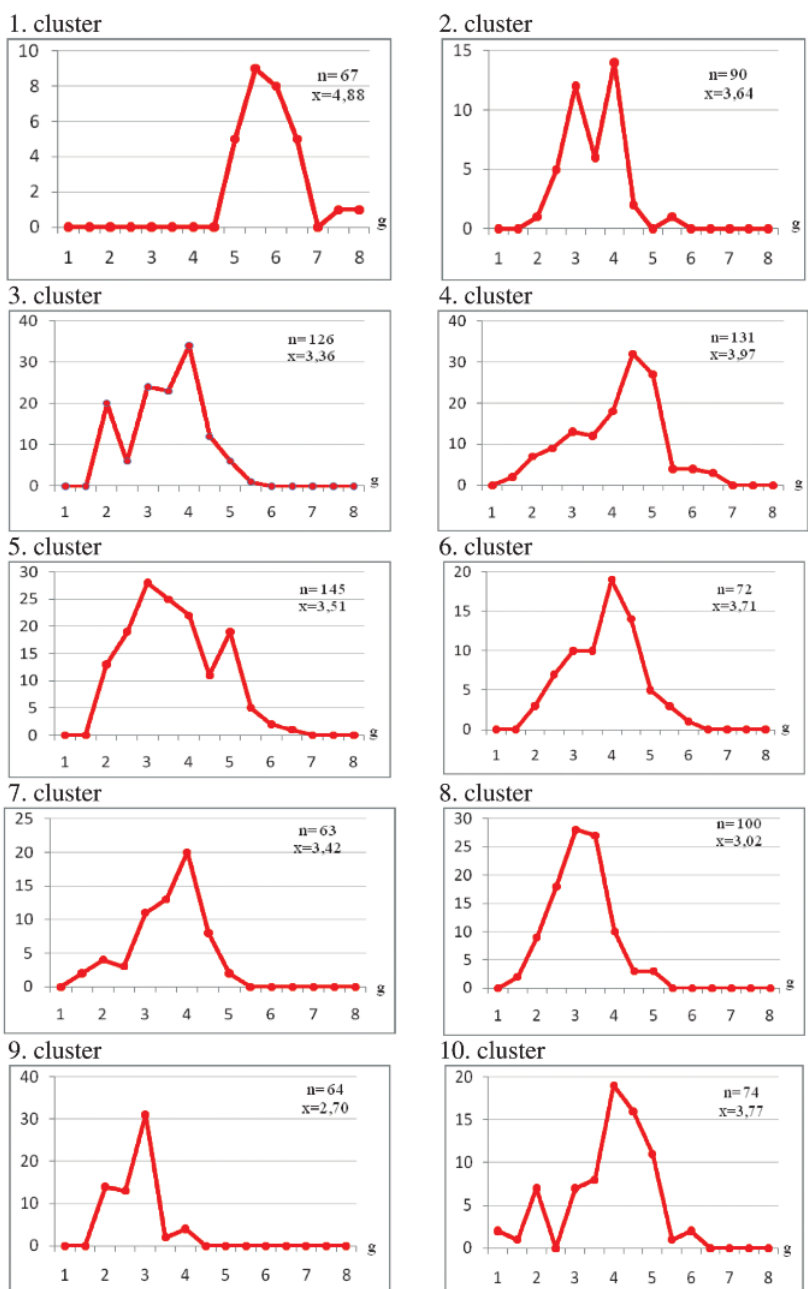
Fig. 17. Weight distribution/cluster (g) of Pannónia kincse